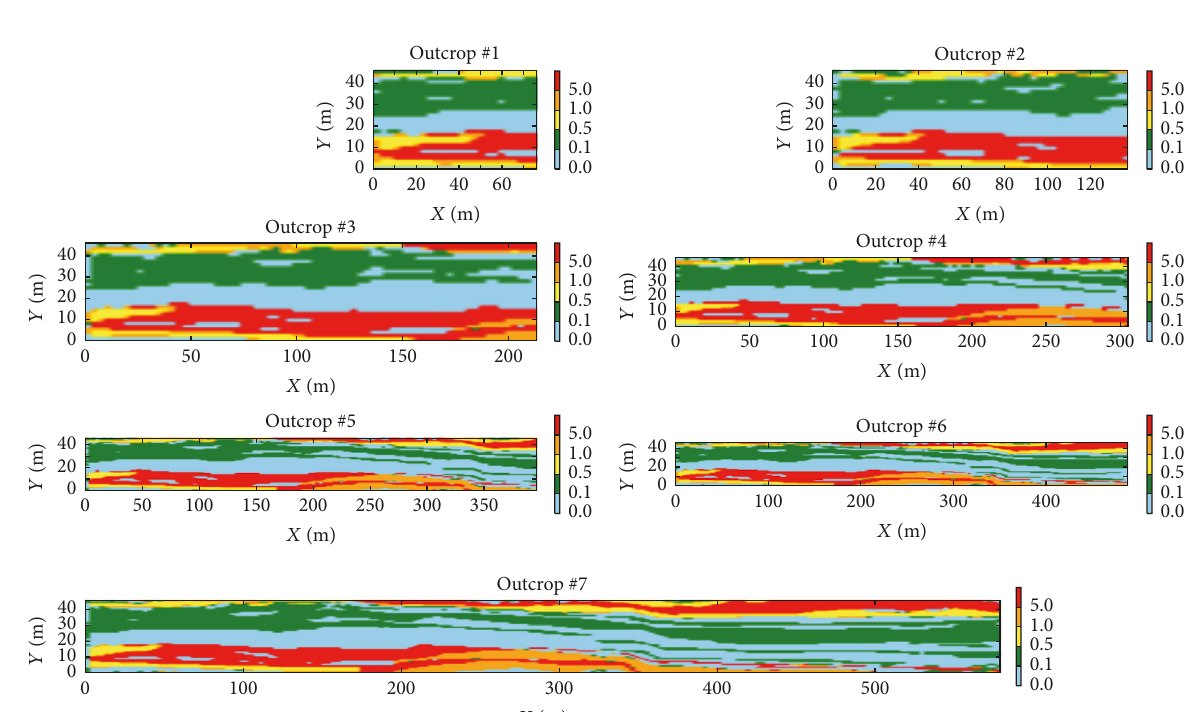
Figure 5: Map of 𝑦 -direction permeability (md) for seven outcrops at field [78,